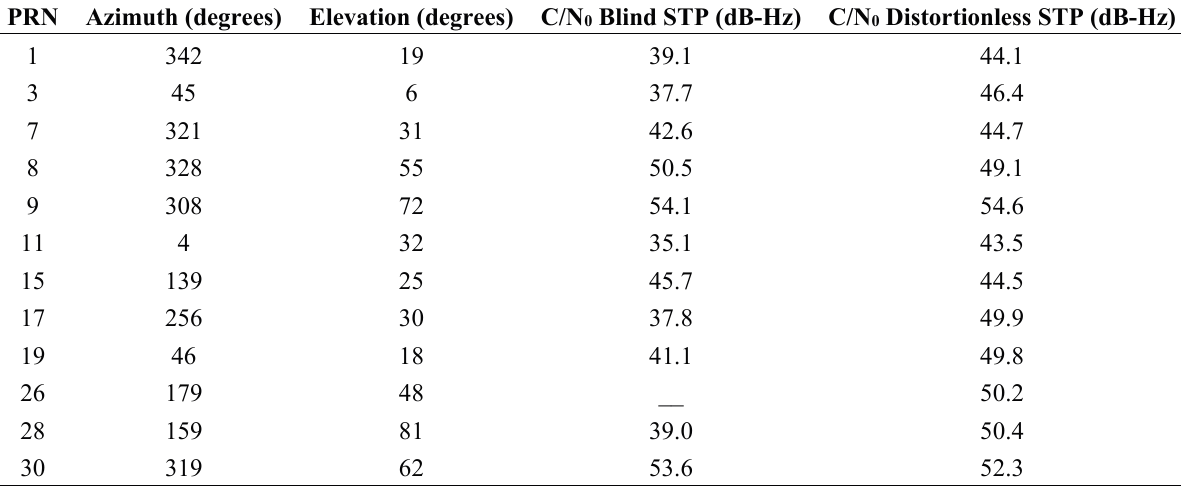
Table 1. PRNs used during test and corresponding azimuth and elevation angles and C/N 0 after each interference mitigation